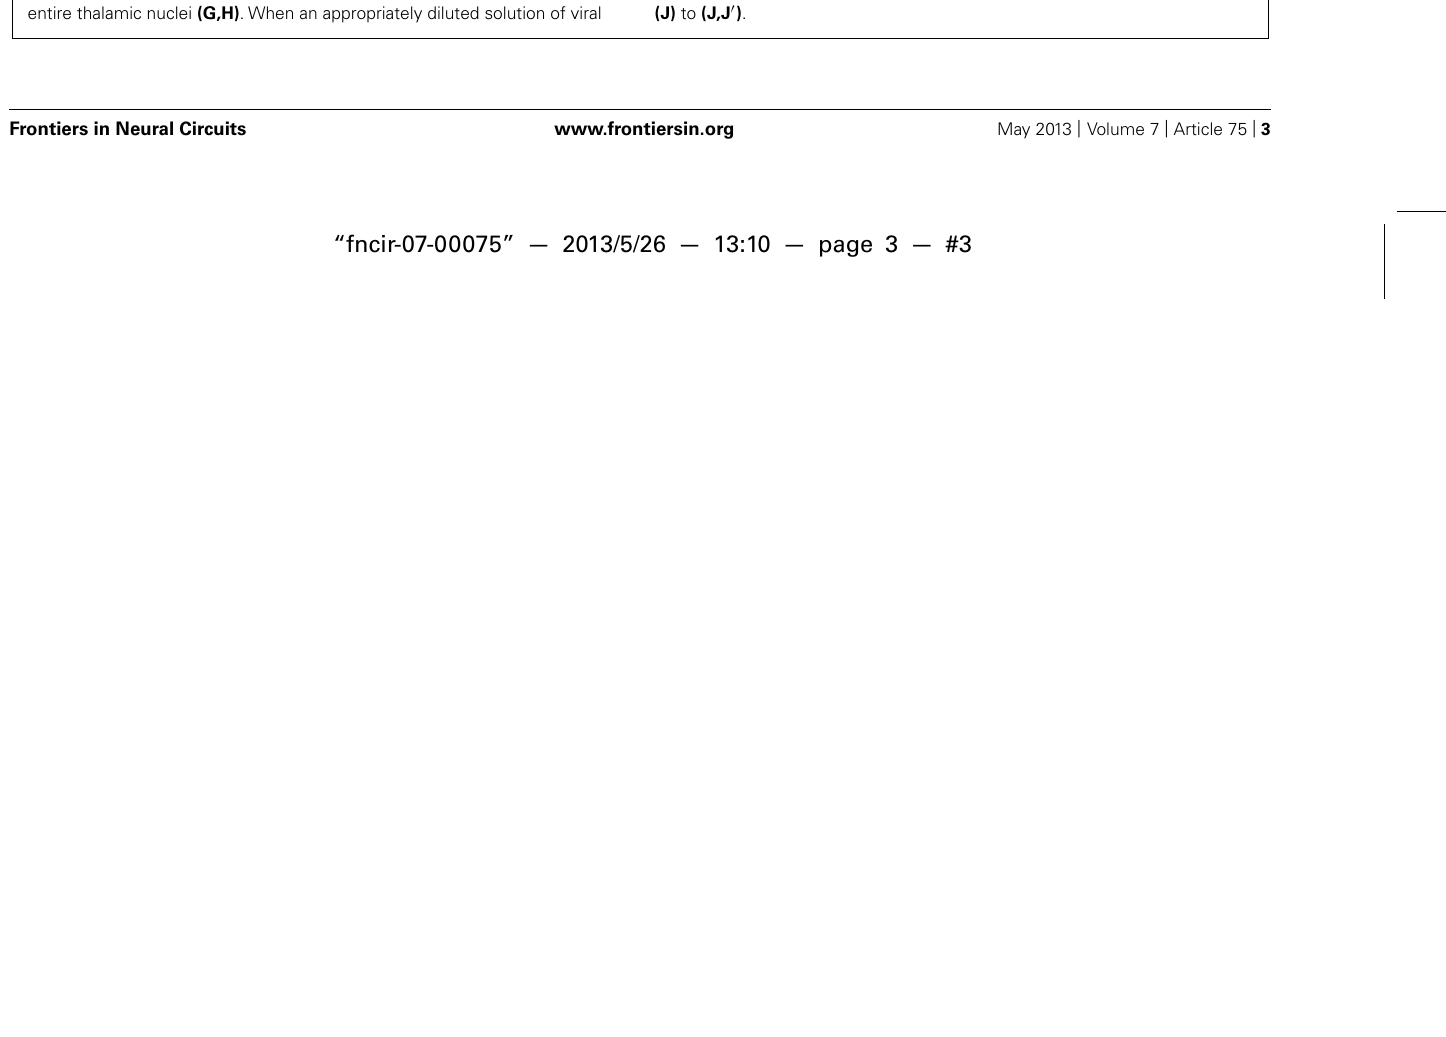
vectors expressing palGFP is injected into theVA–VL, single neurons are labeled green by chance (arrows in I,I (cid:4) ,J ), and visualized up to the tip of the dendrites by the immunoperoxidase staining (J (cid:4) ) . AD, anterodorsal nucleus; APt, anterior pretectal area; AV, anteroventral nucleus; CL, central lateral nucleus; LD, lateral dorsal nucleus; LP, lateral posterior nucleus; ml, medial lemniscus; Pc, paracentral nucleus; Pf, parafascicular nucleus; Po, posterior nucleus; Rt, thalamic reticular nucleus;VM, ventral medial nucleus; VPpc, parvocellular part of the ventral posterior nucleus. Modified with permission from Figure 1 of Kuramoto etal. (2011) and Figure 2 of Kuramoto etal. (2009). Scale bar in (H) applies to (A–H) , that in (I (cid:4) ) to (I,I (cid:4) ) , and that in (J) to (J,J (cid:4) )